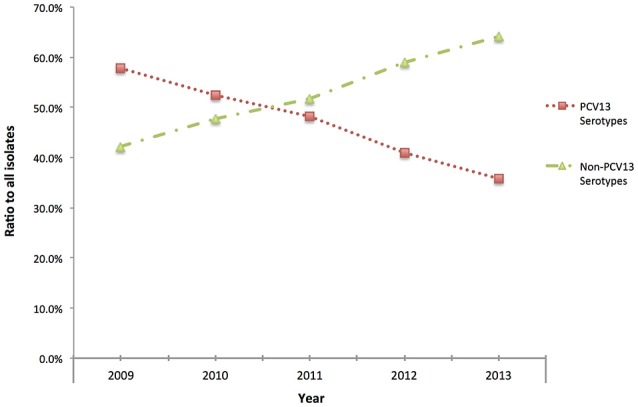
Proportion of Streptococcus pneumoniae isolates causing IPD among older adults (≥50 years of age) expressing PCV13 (1, 3, 4, 5, 6A, 6B, 7F, 9V, 14, 18C, 19A, 19F, and 23F) and non-PCV13 serotypes in Ontario, Canada, during 2009–2013.